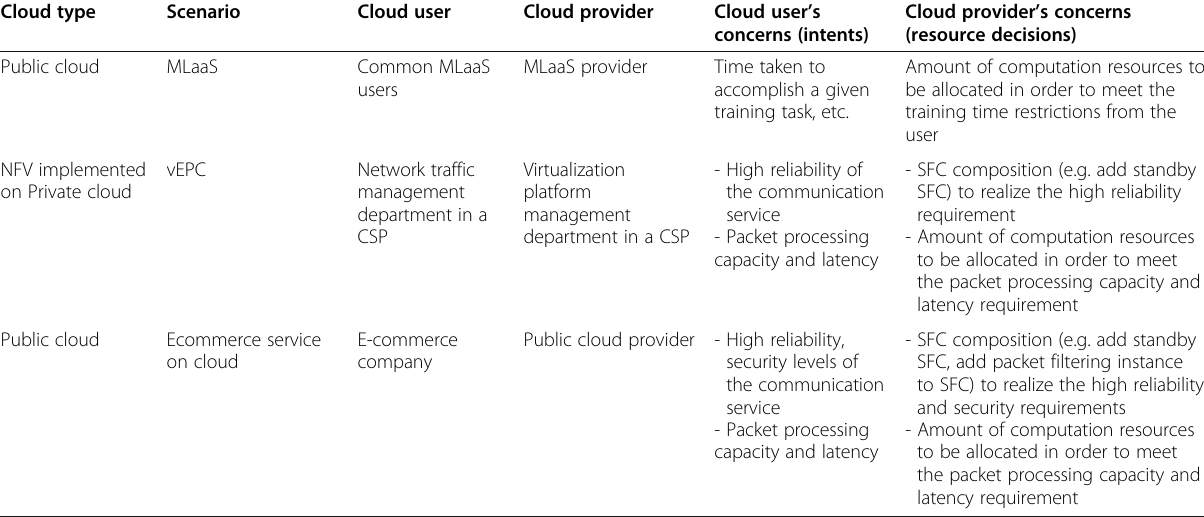
Table 1 Examples where cloud user concerns are about “ What ” while the cloud provider needs to decide “ how ” Cloud